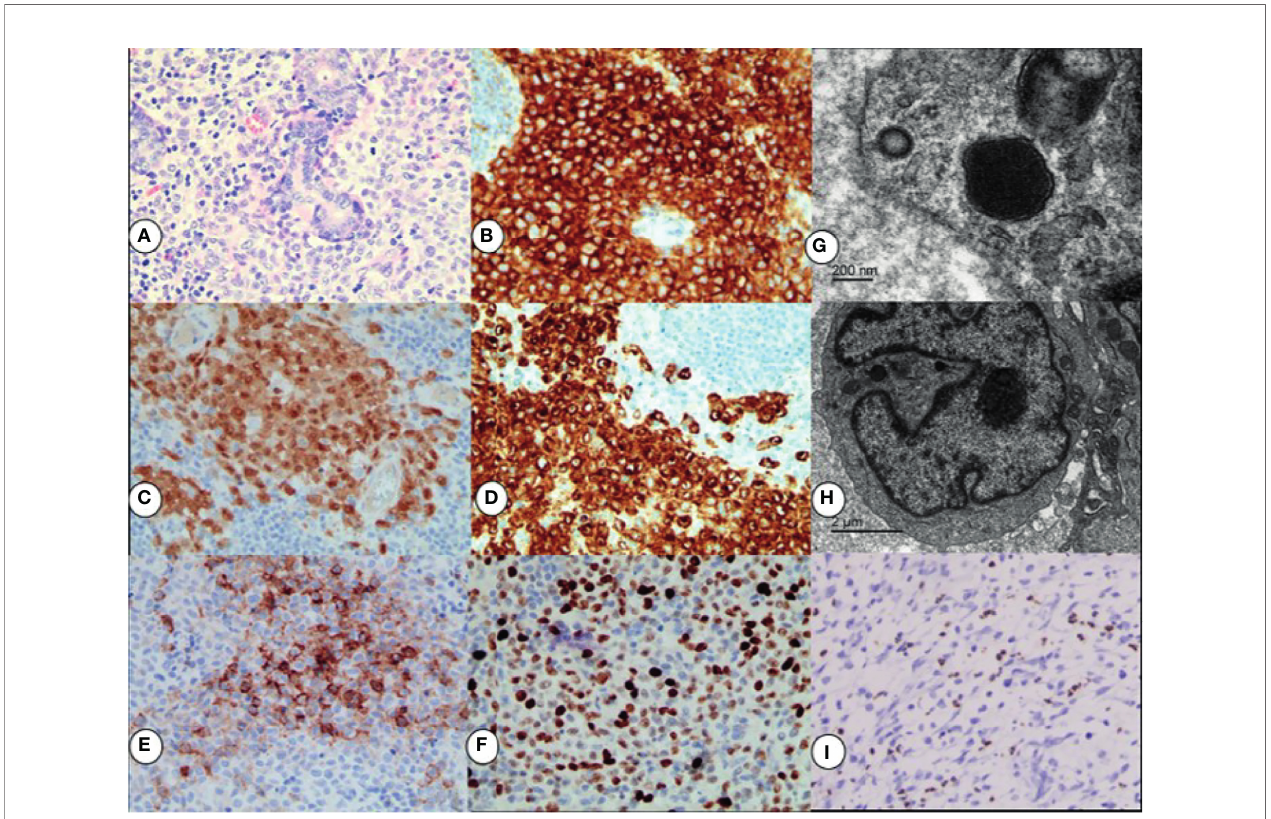
FIGURE 2 | By H&E staining results: the neoplastic cells exhibited cytological atypia, hyperchromatic nuclei, prominent nucleoli, and a high mitotic rate (A) . Immunohistochemical staining for CD1a + (B) , S-100 + (C) , Langerin+ (D) , and CD56+ (E) ; the Ki67 proliferation index was ∼ 60% (F) . All magni fi cations ×40. Electron micrograph showing a large kidney ‐ shaped nucleus (G) and typical Birbeck granules (H) in neoplastic cells. EBER in situ hybridization indicating positive signals in the nuclei of background lymphocytes (I) ,